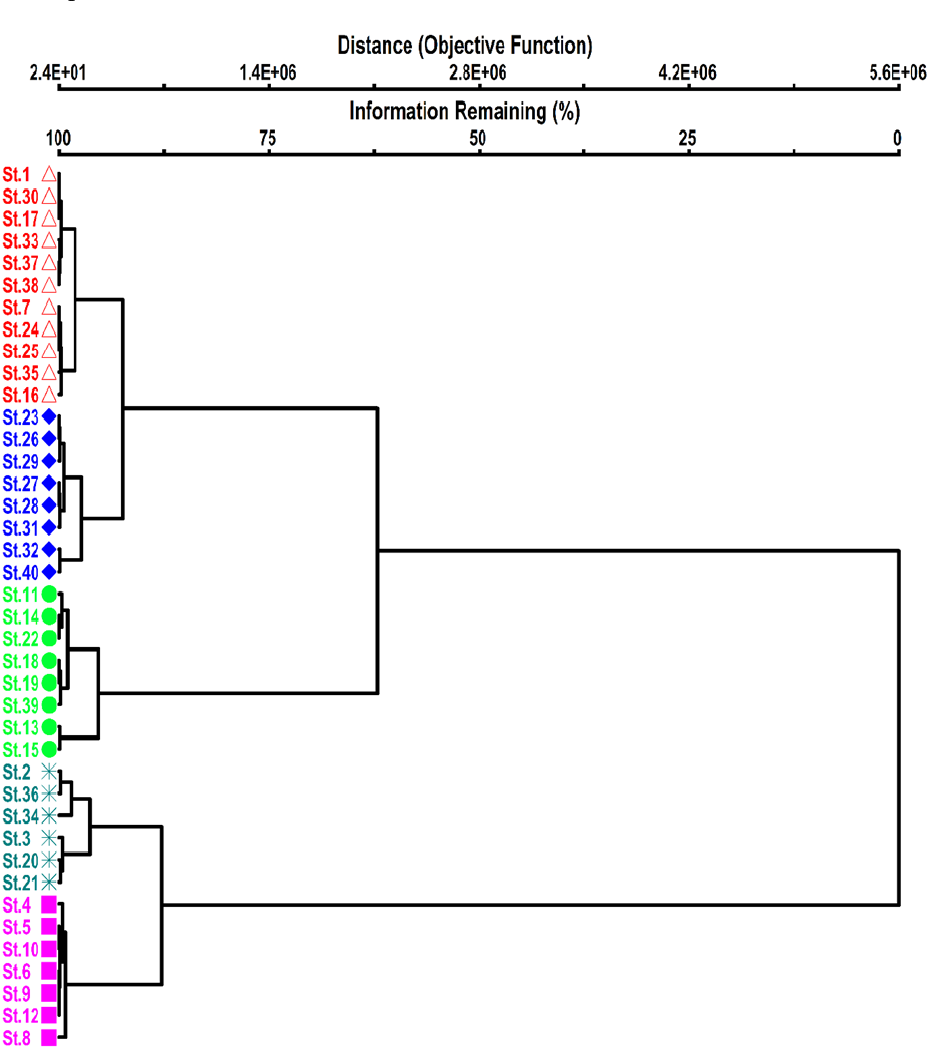
Figure 4. Ward’s cluster analysis of the understory vegetation based on frequency. The understory species indicates five distinct groups. (St indicates different stands in groups of vegetation.) Table 5. Average frequency of the understory vegetation of four main groups was derived from Ward’ s cluster analysis.